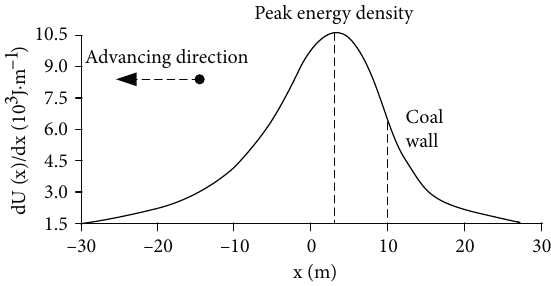
Figure 10: Hanging roof energy density variation